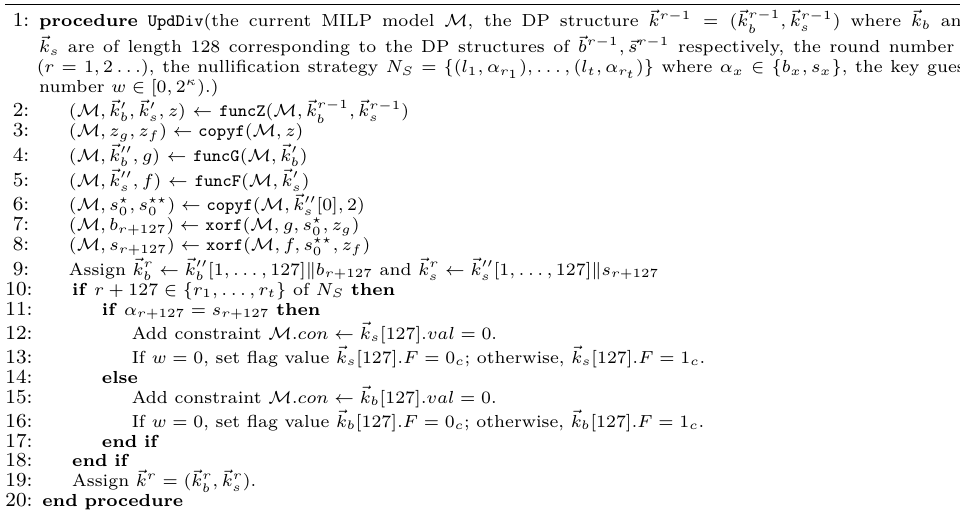
Algorithm 6 MILP model for the Upd of Grain-128 under dynamic cube attack